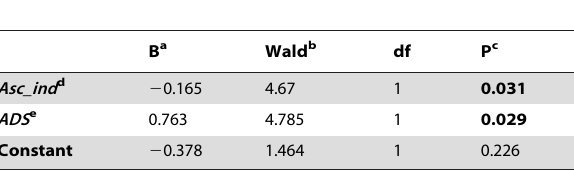
Table 2. Results for SNP detection variables for predicting SNP assay conversion following a backward stepwise elimination procedure.